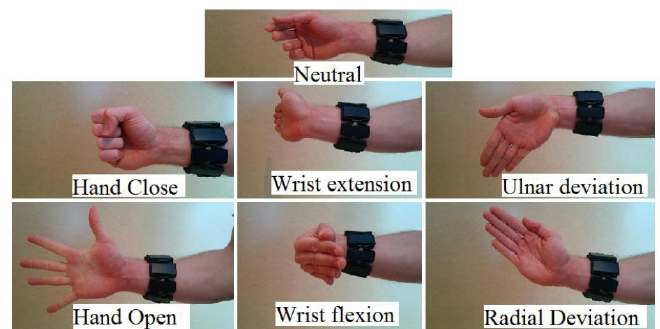
Figure 7. The 7 hand / wrist gestures in the Myo Dataset. In the Myo dataset, seven gestures are included: Netral, Hand Close, Wrist Extension, Ulnar Deviation, Hand Open, Wrist Flexion, and Radial Deviation.